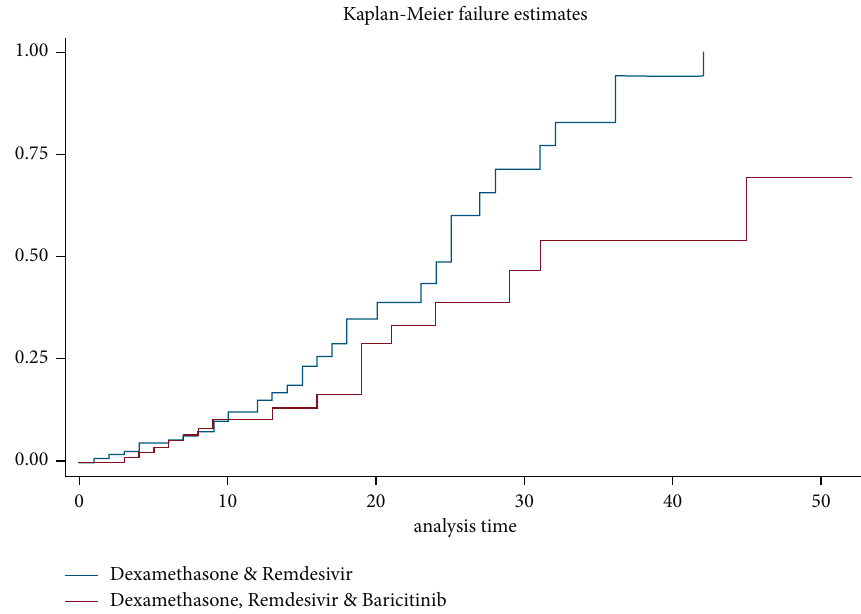
Figure 2: Kaplan–Meier failure estimates between control and experimental